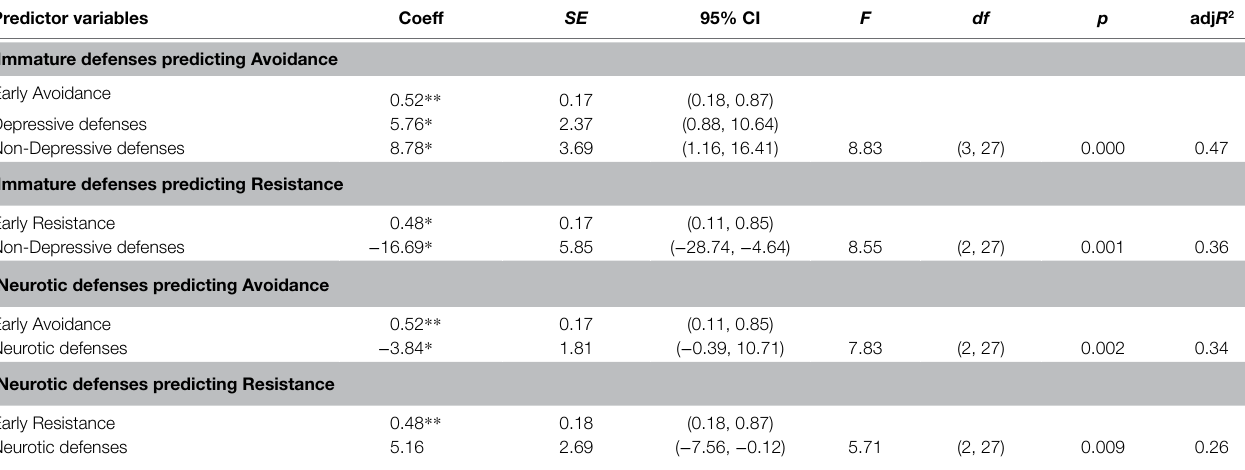
TABLE 3 | Regression models for early DMRS defense mechanisms predicting late PACS attachment-related characteristics. Predictor variables Coeff